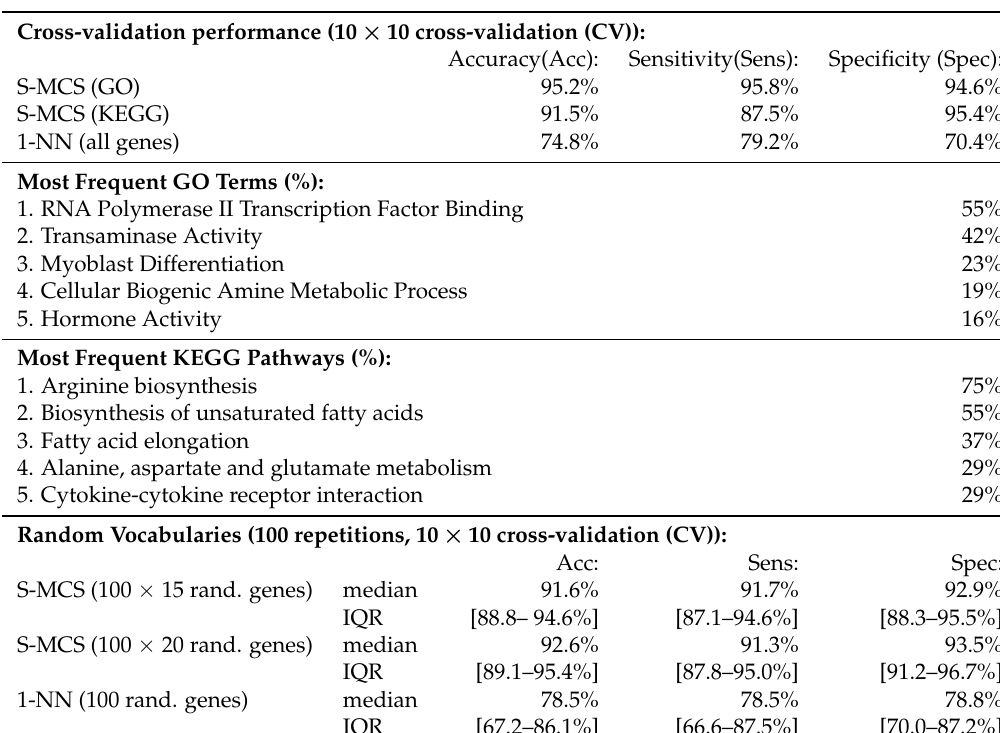
Table 1. Results of the 10 × 10 cross-validation experiments (zebrafish). The average accuracy, sensitivity (mutation) and specificity (control) is reported for the semantic multi classifier system (S-MCS) and the 1-nearest neighbor (1-NN) classifier. Additionally, the five most frequently selected KEGG pathways and GO terms are shown (%). The table additionally provides results of experiments with vocabularies comprising 100 sets of randomly selected (with replacement) genes (cardinality per set: 15 or 20). Median average accuracy, sensitivity, and specificity together with interquartile range (IQR) are